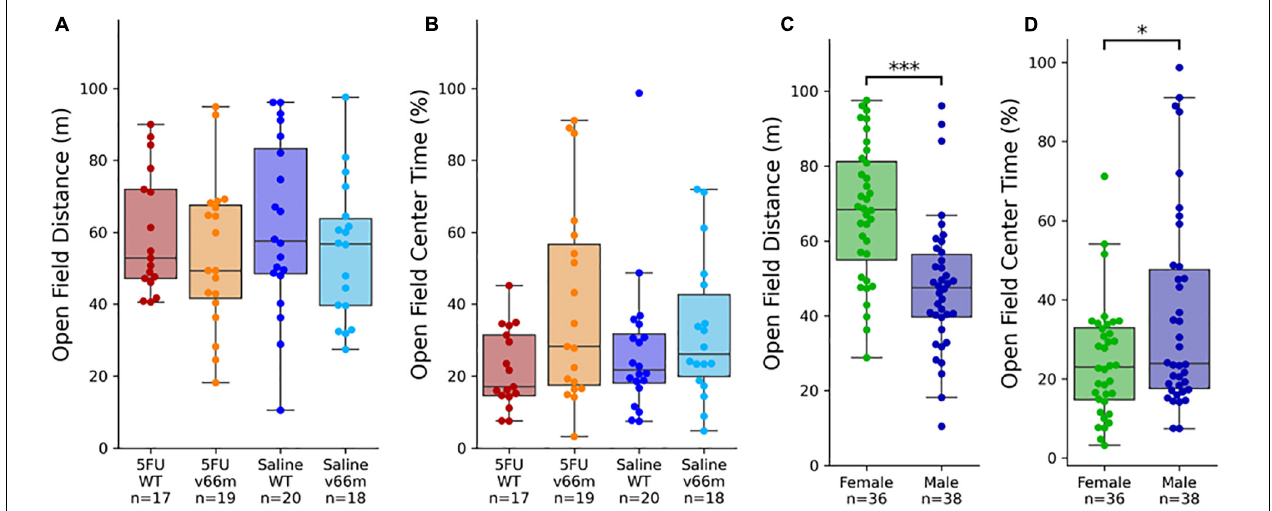
FIGURE 3 | Open field behavior after 5FU injection. (A,B) There were no significant effects of 5FU nor BDNF genotype on open field behavior. (C,D) Female mice traveled significantly longer distances ( p < 10 – 4 ) and spent less time in the center of the arena ( p = 0.018) than male mice. ∗ p < 0.05, ∗∗∗ p <